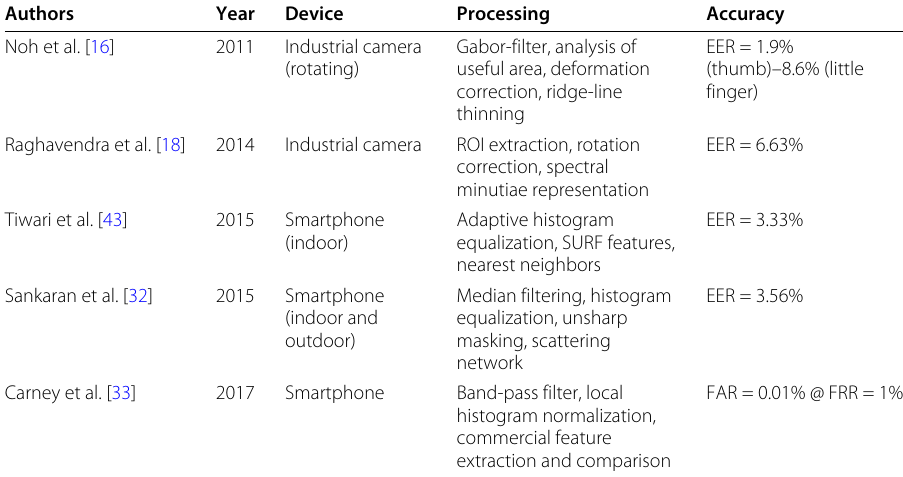
Table 4 Overview on selected recognition workflows with biometric performance